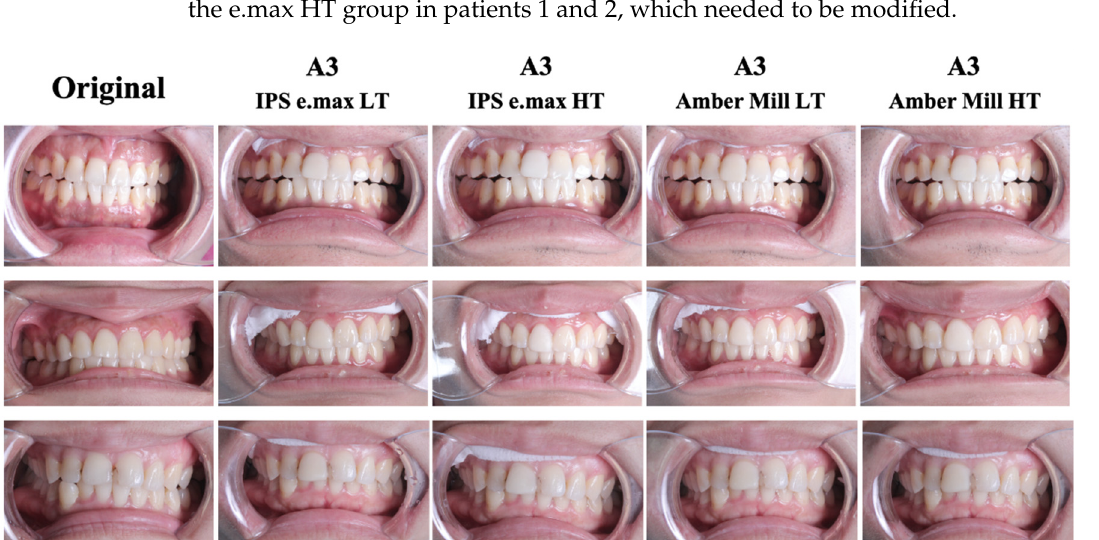
Figure 12. Color difference ( Δ E) values of A3 color glass-ceramics placed in the human oral cavity. Means with different letters differ significantly ( p < 0.05, mean ± SD, n = 3).